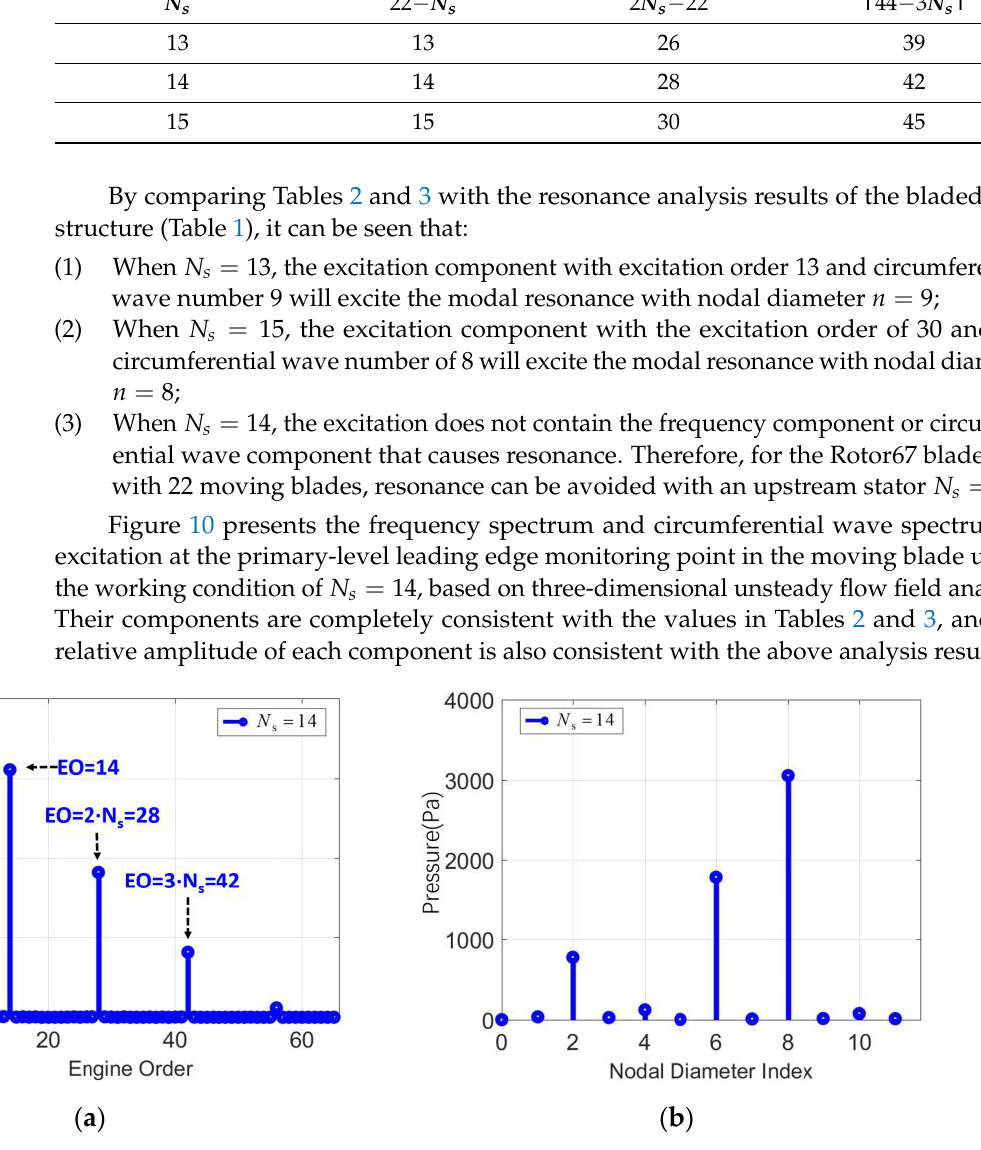
Figure 10. Wake at the leading edge of rotor blades ( N s = 14): ( a ) frequency spectrum; ( b ) circumfer- ential wave